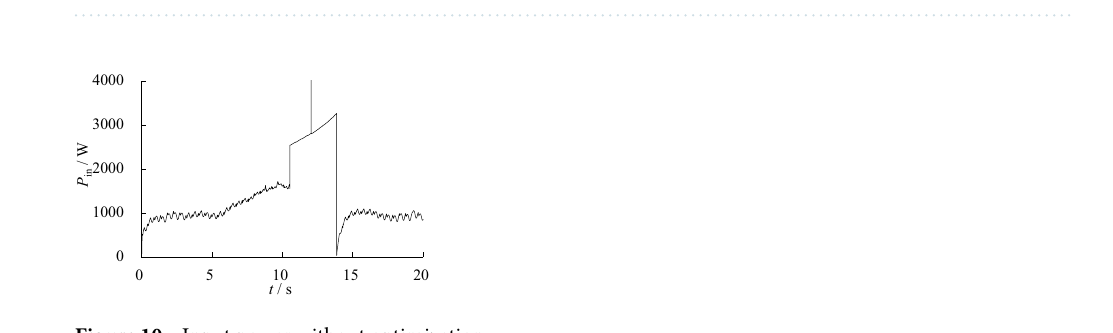
Figure 9. Actuator input/output power without optimization.